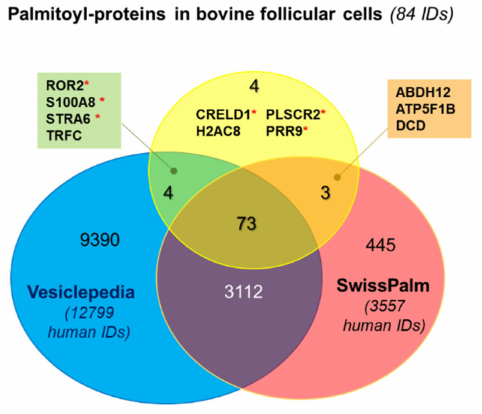
Figure 1. Comparative analysis of palmitoyl-proteins identified in bovine follicular cells. Venn diagram shows the comparison of the list of bovine palmitoylated proteins (84 unique IDs) with human databases SwissPalm (palmitoylated proteins, 3557 IDs) and Vesiclepedia (extracellular vesicle proteins, 12,799 IDs). Red asterisks signify that palmitoylation sites were predicted in this protein. We then compared the lists of the proteins identified from bovine follicular fluid exosome-like EVs (294 IDs) [45], cumulus cells (1381 IDs) [52], granulosa cells (418 IDs) [45], and bovine oocytes (1936 protein IDs) [53] with the list of follicular palmitoyl-proteins (Figure 2a). 32 IDs, 48 IDs and 43 IDs of follicular palmitoy-proteins were shared with GC, CC and oocyte proteomes, respectively. 27 IDs of palmitoyl-proteins were found in follicular fluid EVs. In order to reveal possible origin of these palmitoylated EV proteins, expression of correspondent genes was analyzed in GC, CC and oocytes. As shown in Figure 2b, most of the genes were overexpressed in somatic follicular cells (GC and CC), or similarly expressed as compared to the oocytes. The data of differential analysis is reported in Supplementary Materials (Table S1).